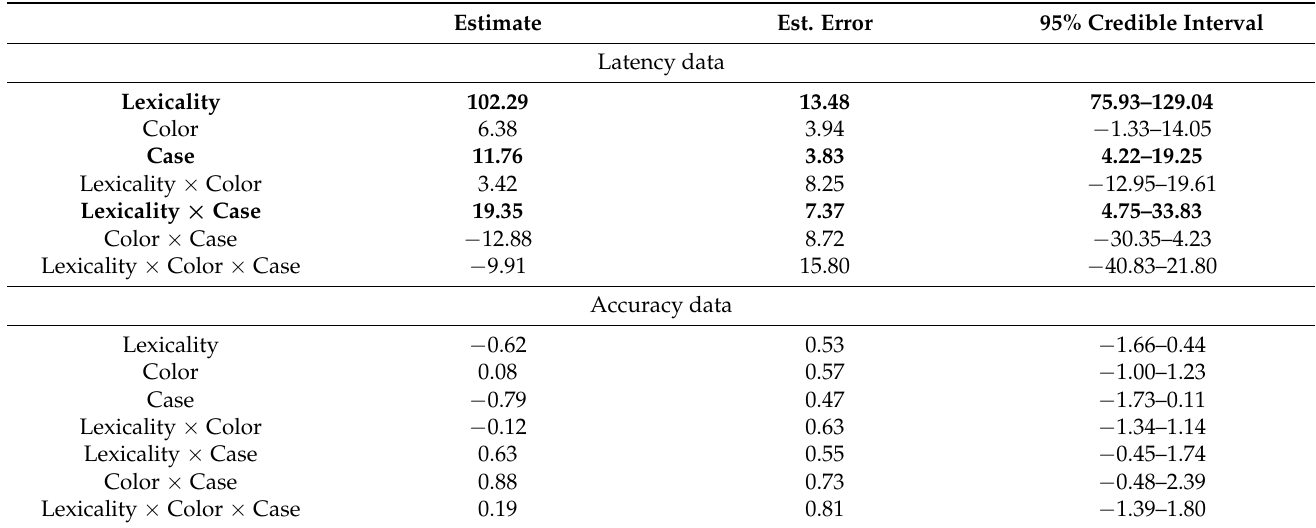
Table 2. Estimates from the Bayesian linear mixed-effects models for each of the critical conditions in the latency and accuracy analyses of the experiment.